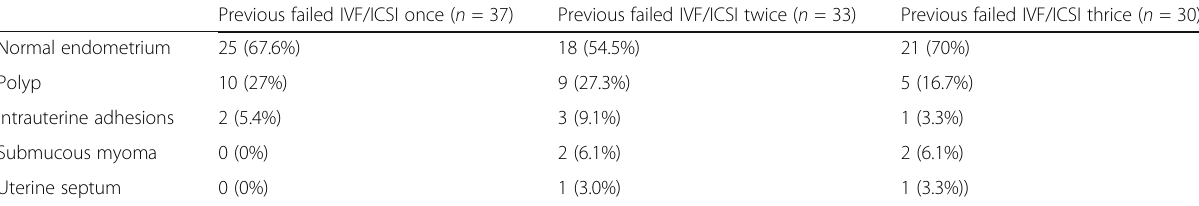
Table 2 The association between the no. of previous failed IVF/ICSI trials and hysteroscopic findings Previous failed IVF/ICSI once ( n = 37) Previous failed IVF/ICSI twice ( n = 33)